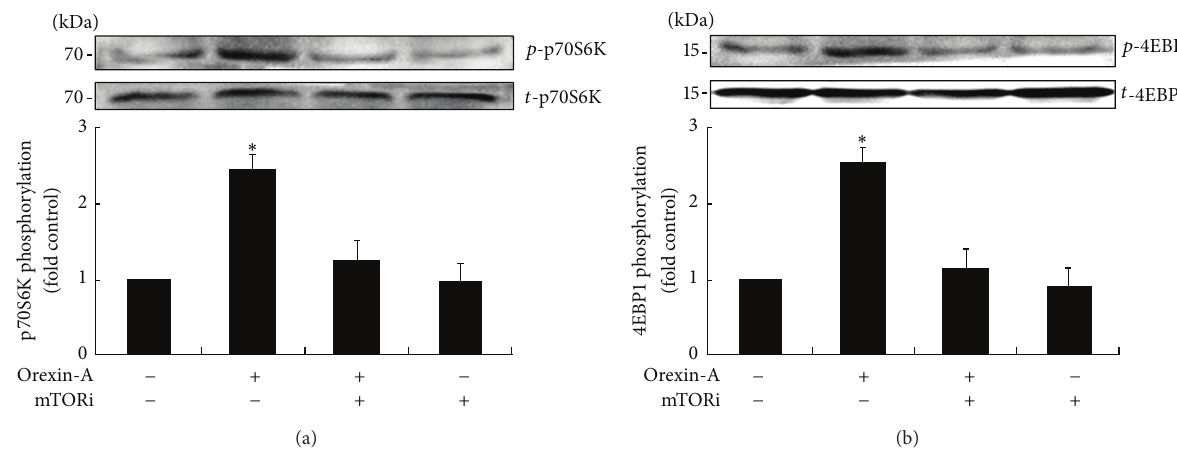
Figure 3: Orexin-A signals through the p70S6K/4EBP1 pathways. Cells were stimulated with orexin-A at concentration of 10 −6 M, in the presence of PF-04691502 (10 −6 M). Autophosphorylation of p -p70S6K/ p -4EBP1 was evaluated along with the total protein activation. Protein activation was measured by western blot analysis. Data are presented as mean ± SEM of four independent experiments. Asterisks indicate significant differences compared to control samples ( ∗ 𝑃 < 0.05 ).